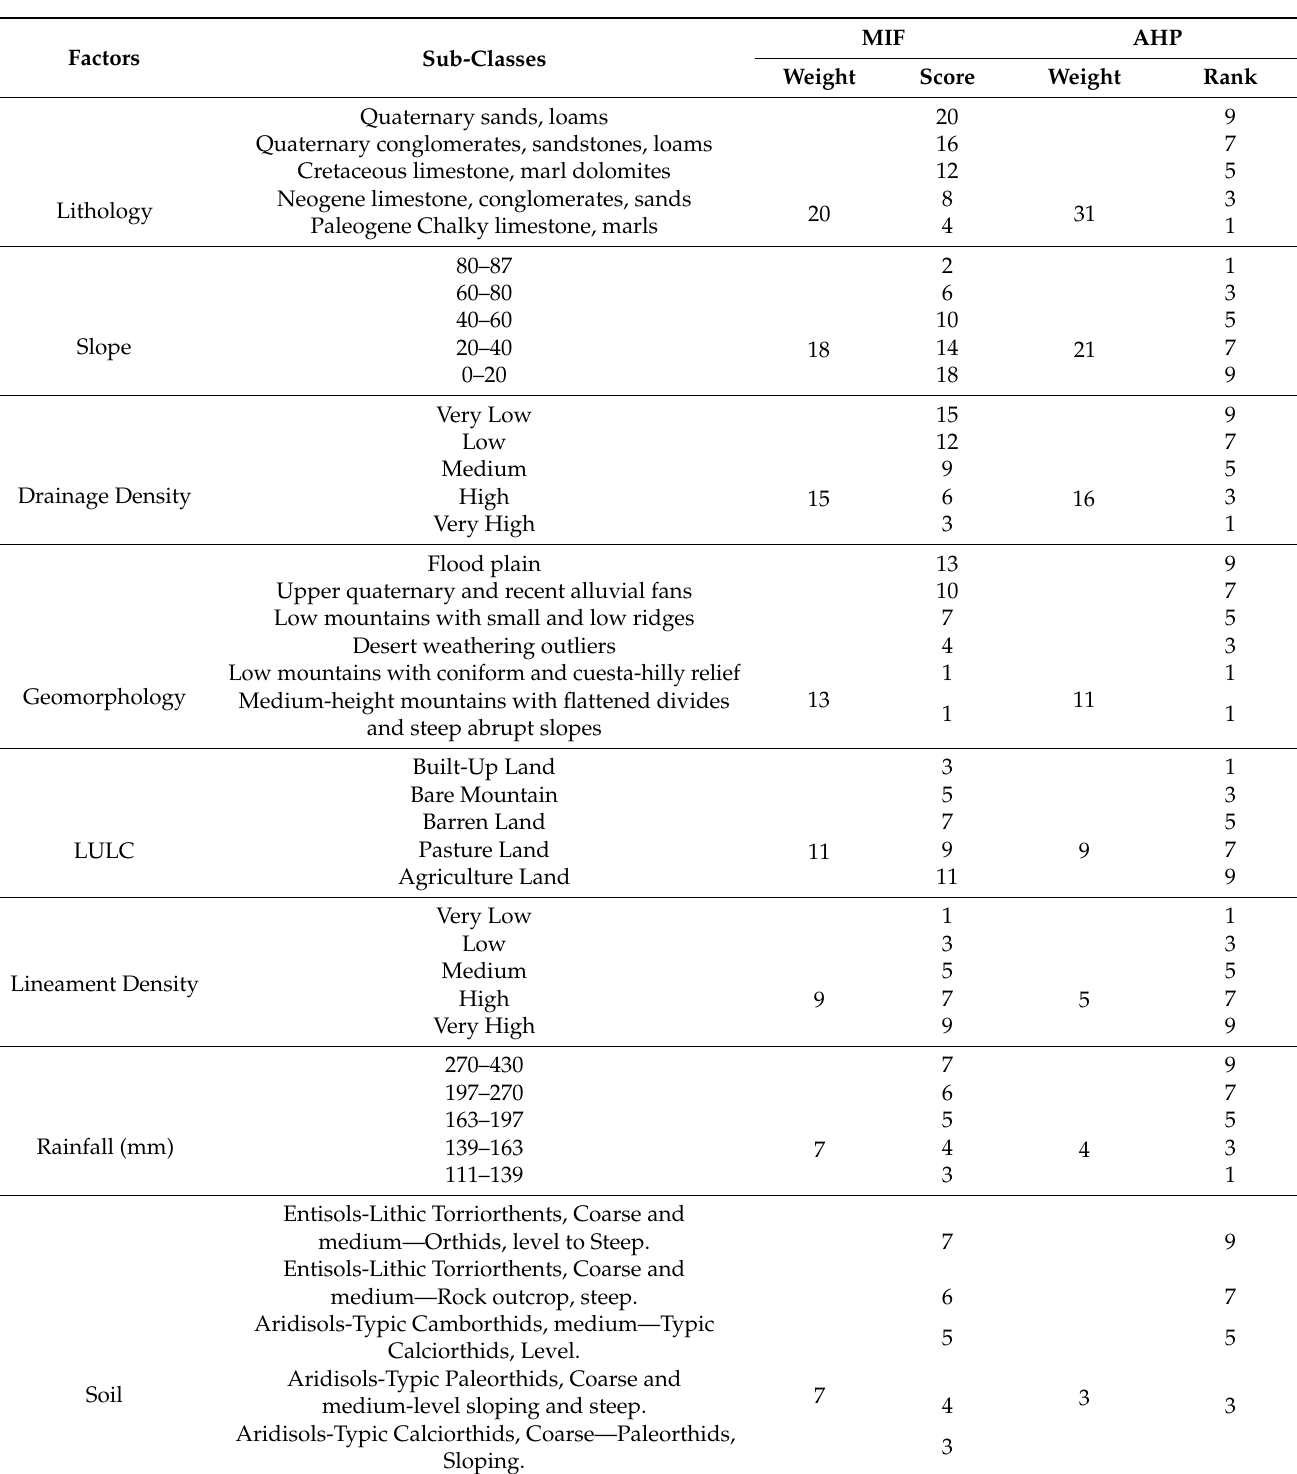
Table 6. Weight and scores of specific characteristics that were assigned to factors that influence